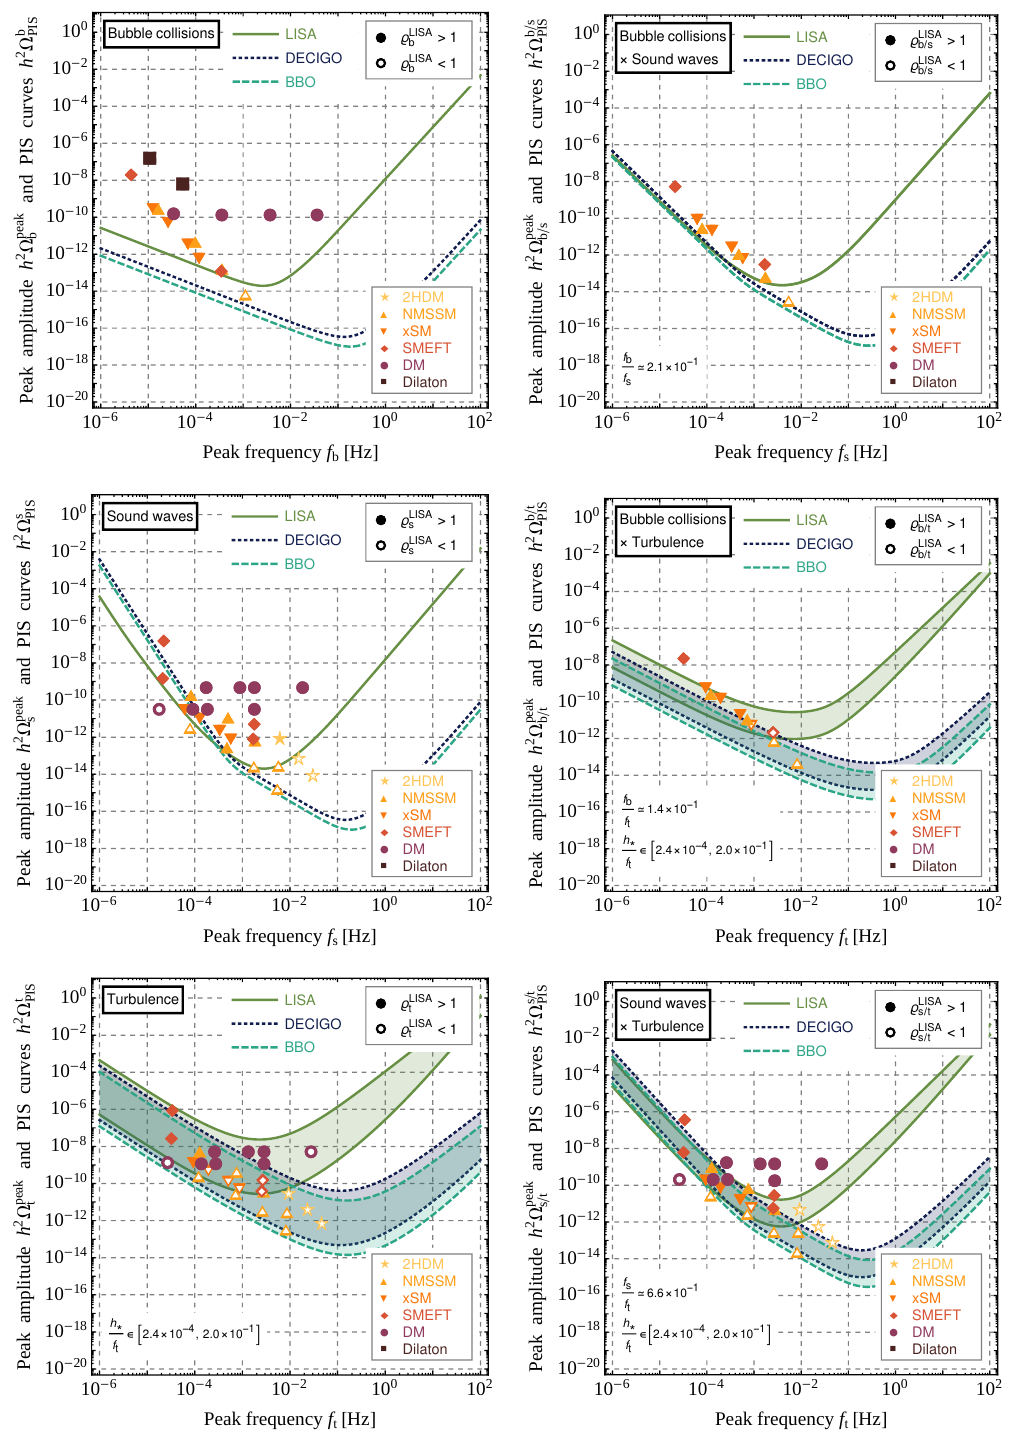
Figure 4 . PISCs for LISA, DECIGO, and BBO together with the predictions of all BPs. See